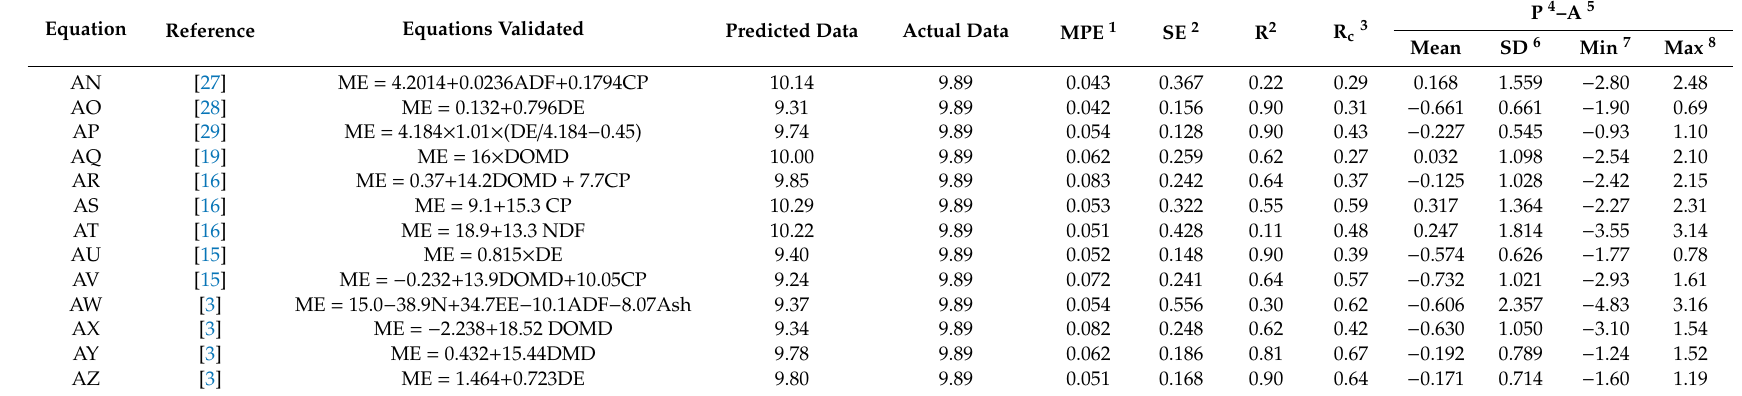
Table 8. Validation of equations published elsewhere for prediction of ME concentration using one-third of the present dataset ( n = 22).